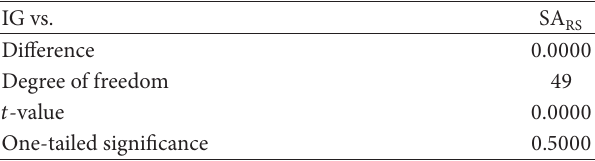
Table 7: Paired 𝑡 -tests on the average RER for I2 problem set.